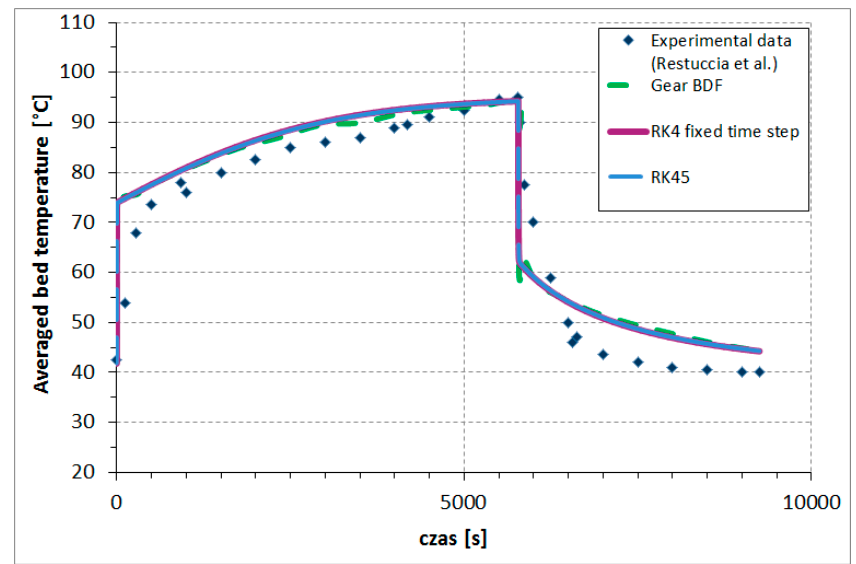
Figure 4. Comparison between the time variations of the presented numerical methods and experimental averaged bed temperatures. (Restuccia et al. [21]).